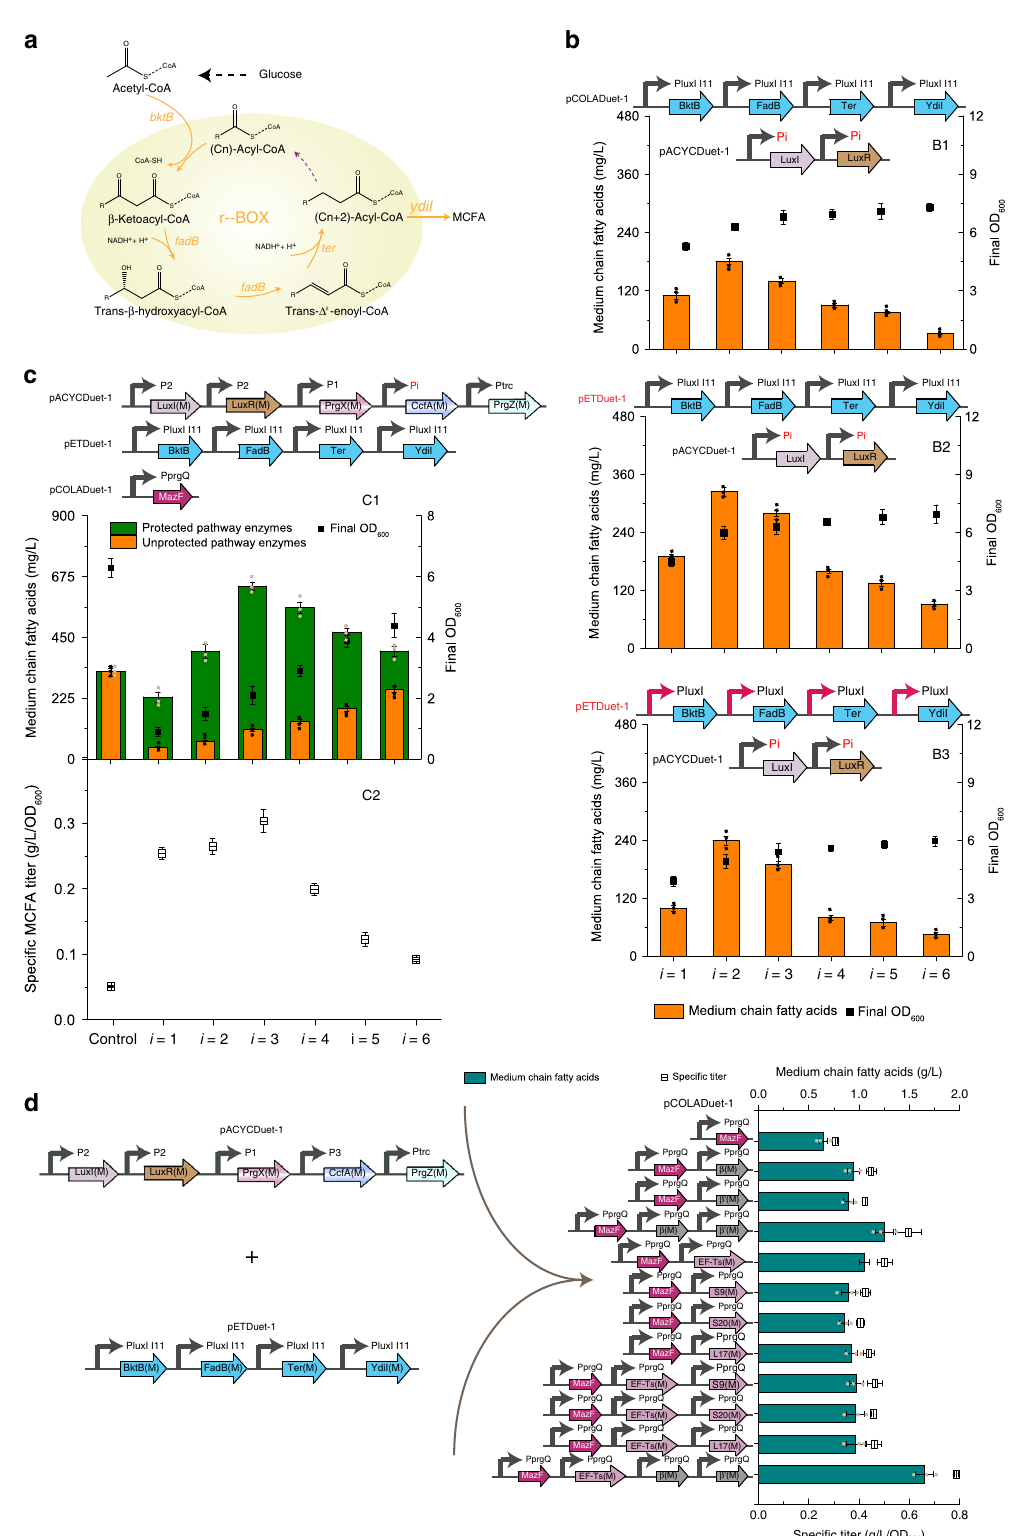
Fig. 6 Enhancing metabolic production yields by resource allocator circuits. a Schematic of r-BOX cycle. b The r-BOX cycle was driven by different triggering times of QVX circuits. Pi (i = 1 – 6) indicated using Pi (i = 1 – 6) promoters for LuxI and LuxR expression. (B1) PluxI I11 response promoters fused with each pathway enzyme were placed on pCOLADuet-1. (B2) PluxI I11 response promoters fused with each pathway enzyme were placed on pETDuet-1. (B3) PluxI I11 was replaced with native PluxI promoter. c The effect of different triggering times of QEX circuits driving MazF expression on MCFA production. Pi (i = 1 – 6) indicated using Pi (i = 1 – 6) promoters for CcfA expression. d The effect of protecting host factors from MazF on MCFA titers. Pre- cultured recombinant strains were grown in 25 mL of MOPS medium at 30 °C with 220 rpm orbital shaking. MCFA titers and cell density (OD 600 ) were measured after 48 h of culture. Values are shown as mean ± SD ( n = 3 biological replicates). Source data are available in the Source data fi